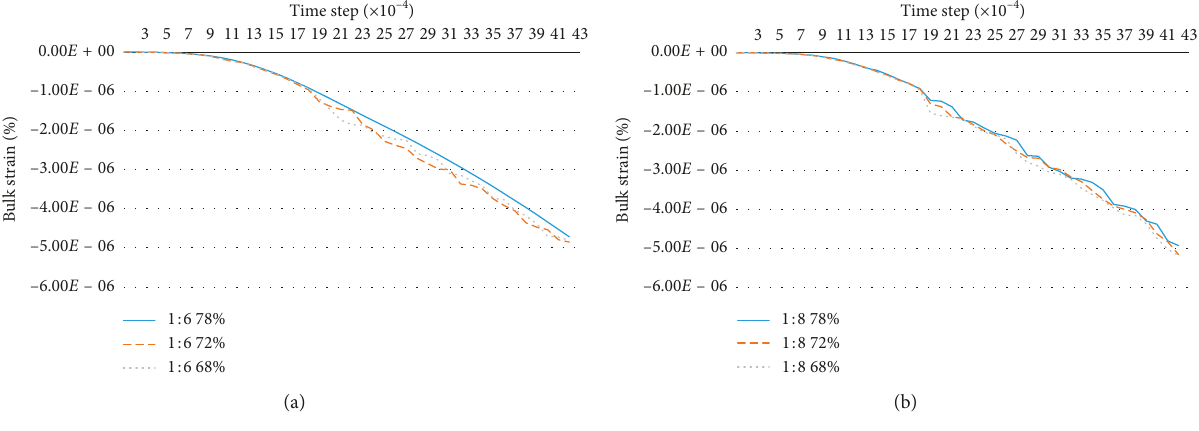
Figure 5: #2 monitoring point bulk strain-time step graph.